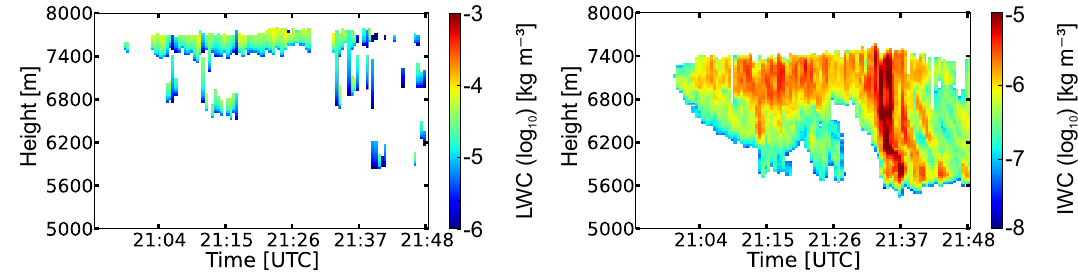
Figure 5. Cloudnet derived water contents for case 2. Left: liquid water content; right: ice water content (both in logarithmic scale).